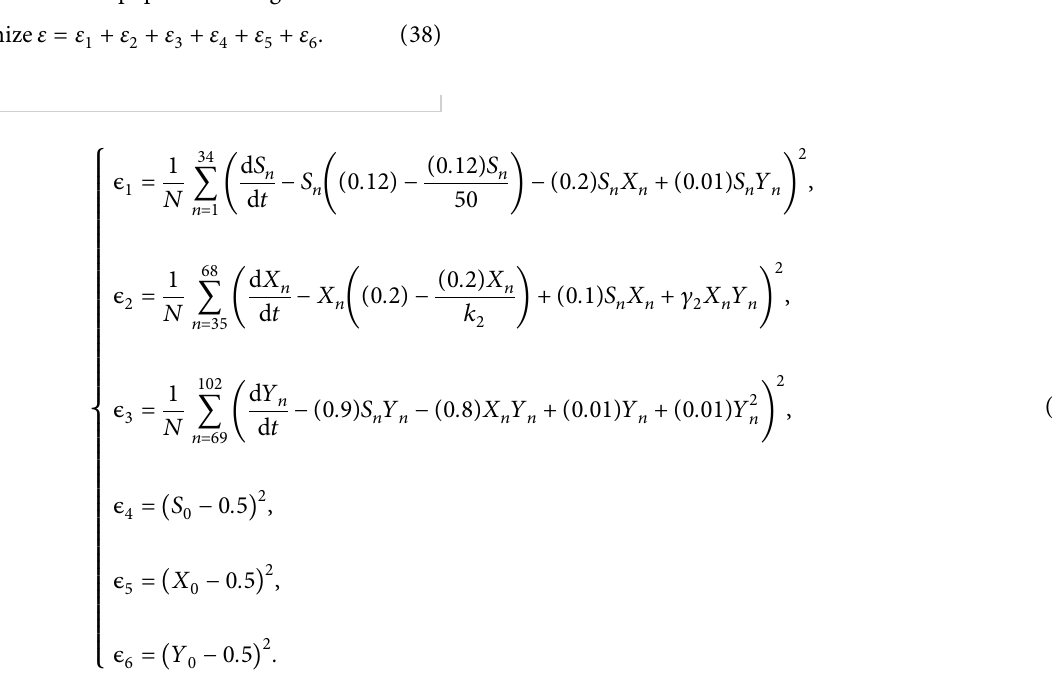
Figure 13: Absolute errors obtained by the LeNN-WOA-NM algorithm under the influence of variations in β the prey-predator model. (a) Population density of local prey. (b) Population density of immigrant prey. (c) Population density of the predator.